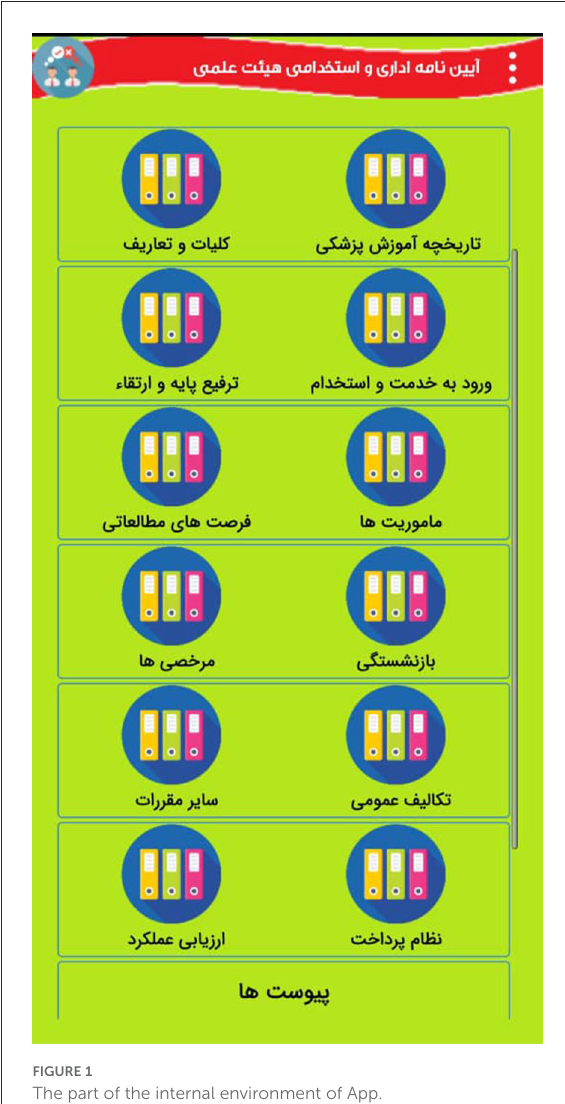
FIGURE1 The part of the internal environment of App.